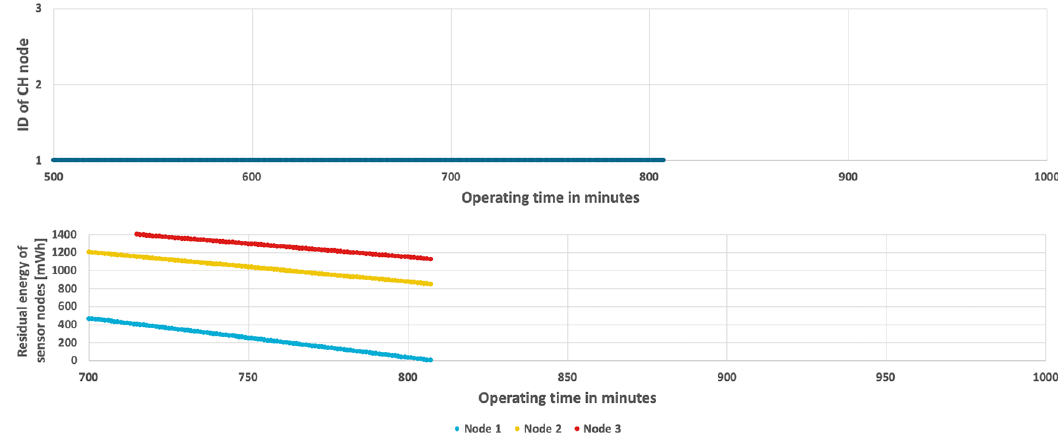
Figure 6. Energy consumption by sensor nodes without CH rotation.